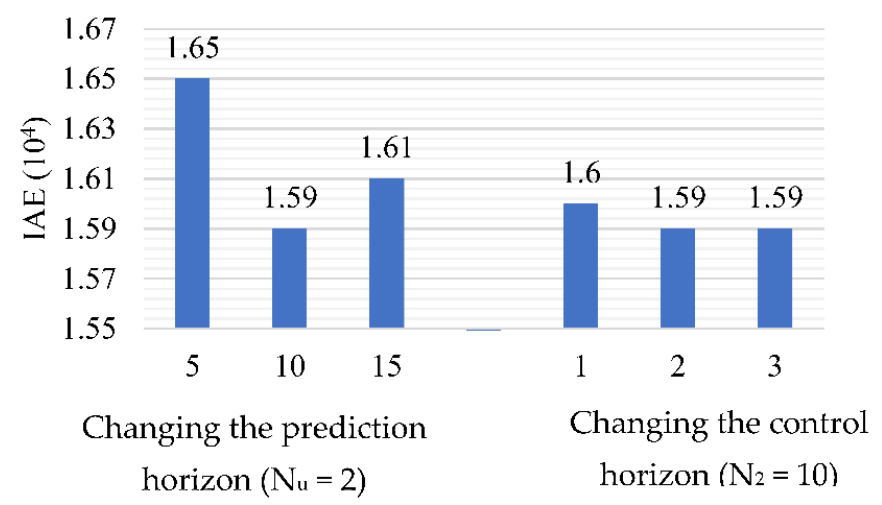
Figure 8. The effect of the prediction and control horizons on IAE.